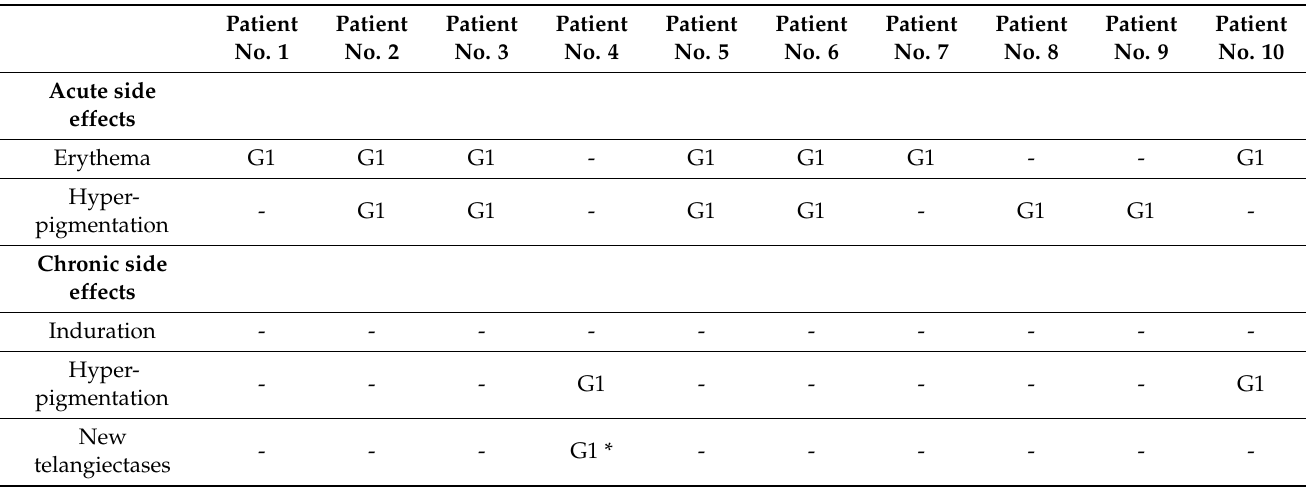
Table 4. Acute and chronic side effects after